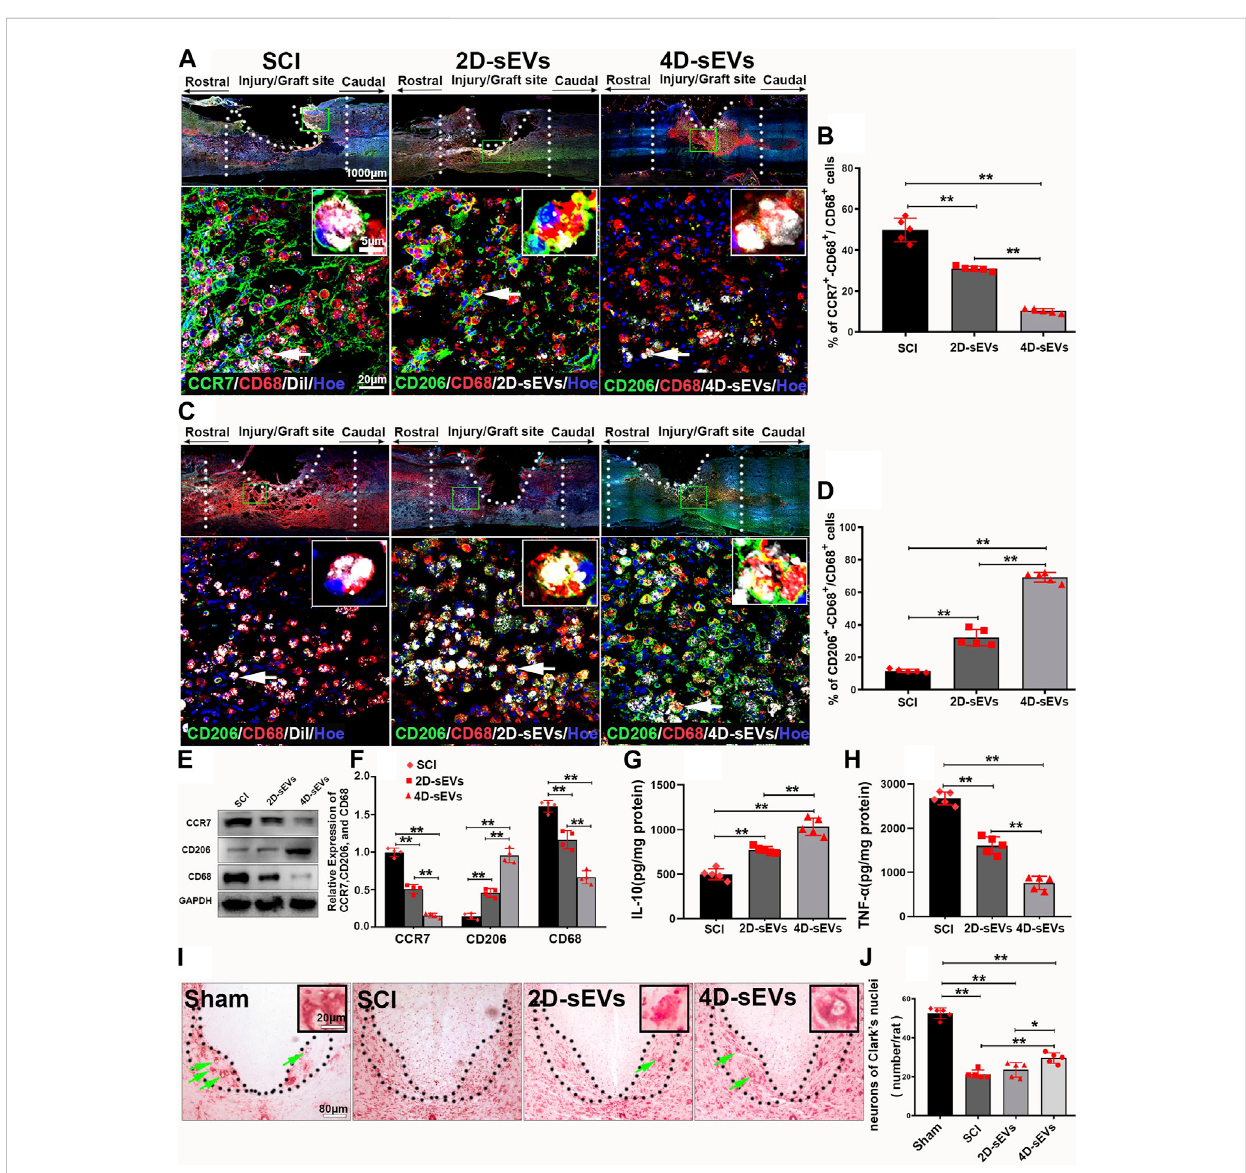
FIGURE 3 Four dimensional culture-derived sEVs polarized the macrophage/microglia phenotype from M1 to M2 to reduce neuroin fl ammation and protect the injured spinal cord neurons. (A) Fluorescently stained images showing CCR7 + (green)/CD68 + (red) M1 macrophage cells in three groups (low magni fi cation and high magni fi cation). (B) Bar charts show the ratio of CCR7 + /CD68 + cells to CD68 + cells in the injury/graft site of the spinal cor. (C) Fluorescently stained images showing CD206 + (green)/CD68 + (red) M2 macrophage cells in three groups (low magni fi cation and high magni fi cation). (D) Bar charts show the ratio of CD206 + /CD68 + cells to CD68 + cells in the injury/graft site of the spinal cord. (E) Western blot analysis of protein expression (CCR7, CD206, CD68). (F) Quantitative analysis of Western blot. (G – H) : ELISA was performed to detect the concentrations of IL-10 and TNF- α from the injury/graft site of the spinal cord. (I) Nissl staining showed the neurons in Clark ’ s nuclei of the L1. (J) Bar charts showing the number of neurons. Statistic difference: * p < 0.05; ** p <